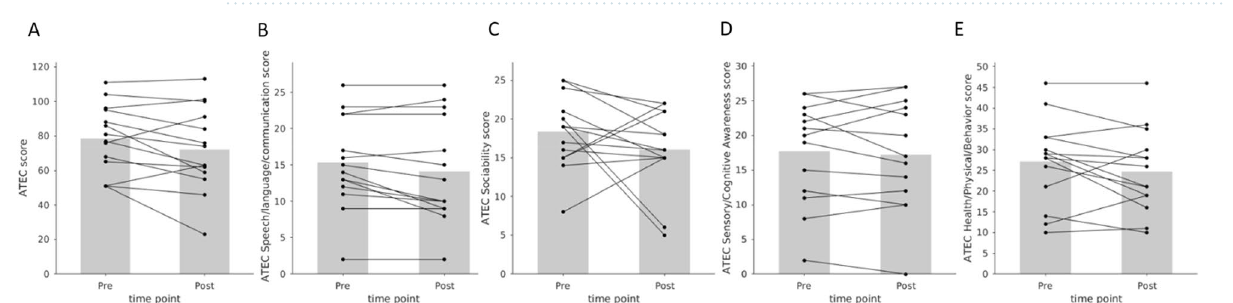
Figure 9. Short-term intervention with the games did not reduce autistic symptoms. The graphs show pairwise comparisons between the pre-intervention and the post-intervention measures of autistic symptoms measured using ATEC total score ( A ), or the four sub-categories of ATEC, namely Speech/Language/Communication ( B ), Sociability ( C ), Sensory/Cognitive Awareness ( D ), and Health/Physical/Behavior ( E ). No significant change was observed in any case.